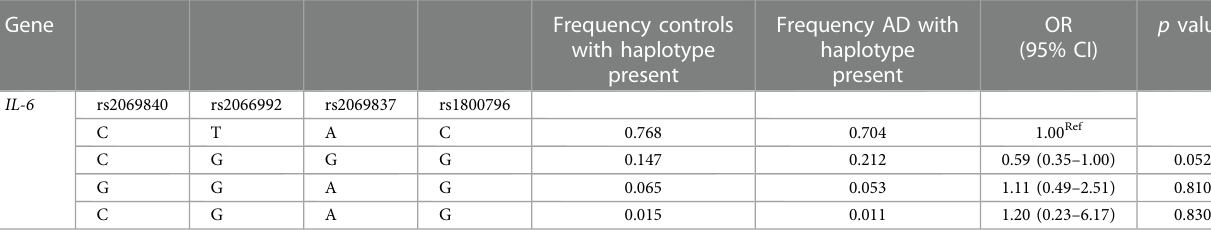
Frequency AD with with haplotype haplotype present present